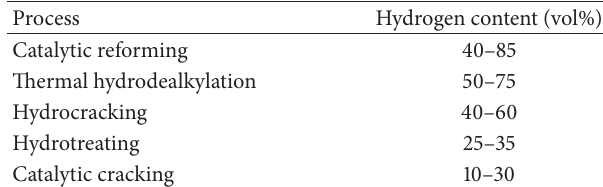
Table 5: Hydrogen composition in refinery off-gases